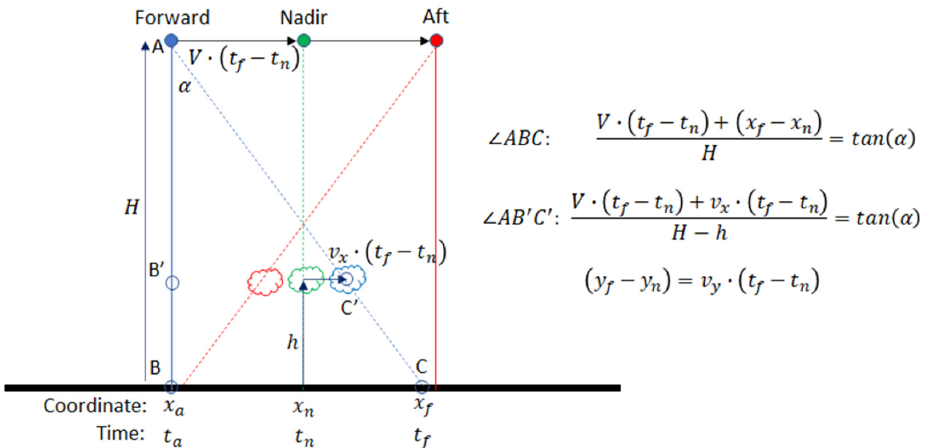
Figure 20. Simplified CMIS configuration allows linear design rules to be derived using elementary geometry. Non-simultaneous forward, nadir, and aft looks are shown for a single camera. Forward and aft coordinates for a cloud feature seen in the nadir look are given at the matched locations in the forward- and aft-looks.